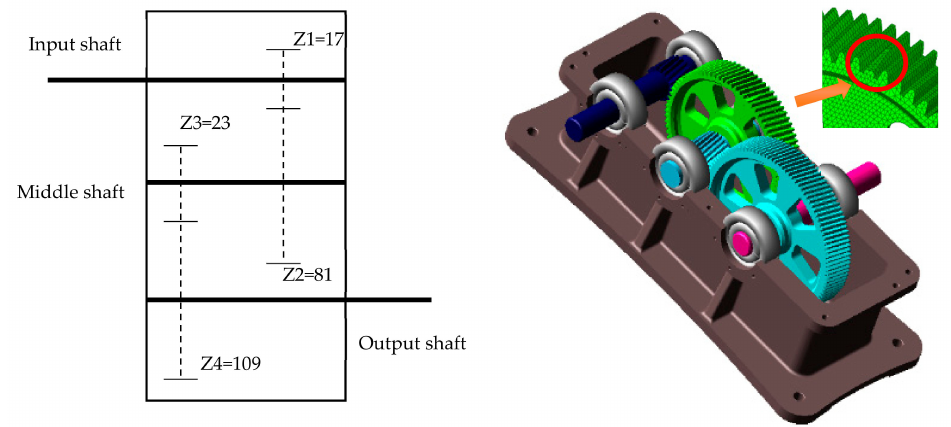
Figure 7. The configuration and dynamical model of the gearbox